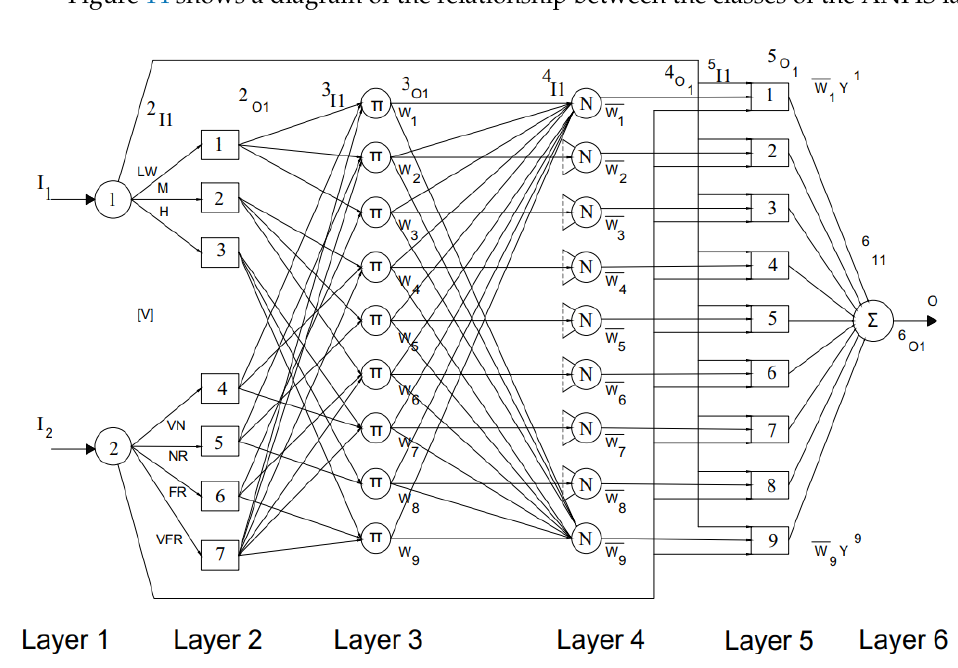
Figure 14. ANFIS architecture.